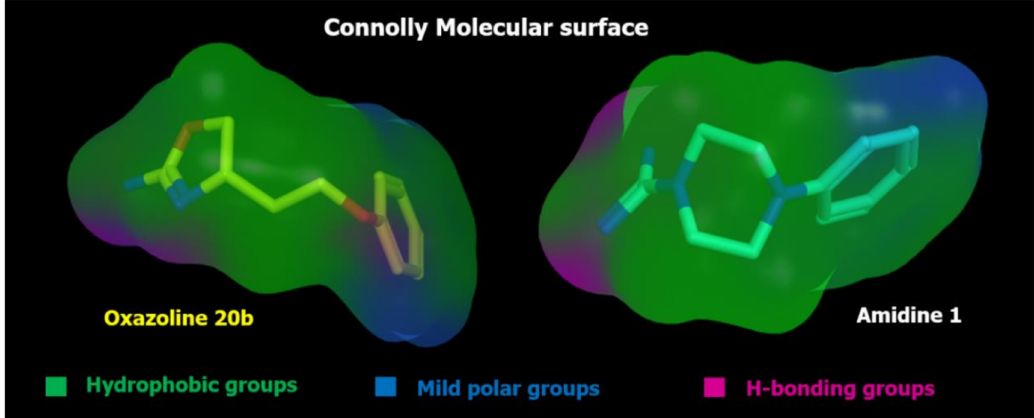
Figure 8. Comparison of the Connolly molecular surface properties of 20b ( left ) and 1 ( right ) in terms of hydrophobic, polar and H-bonding features. Agonists are shown as bold sticks ( C atoms colored in yellow and white,